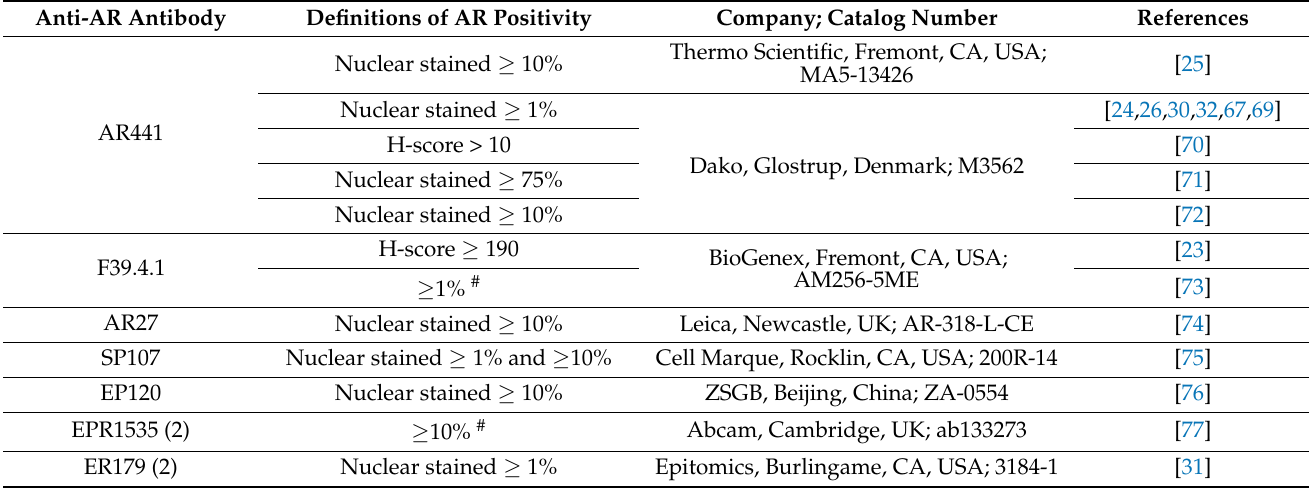
Table 1. The definition of AR positivity as determined by IHC, and the antibodies used varied in different